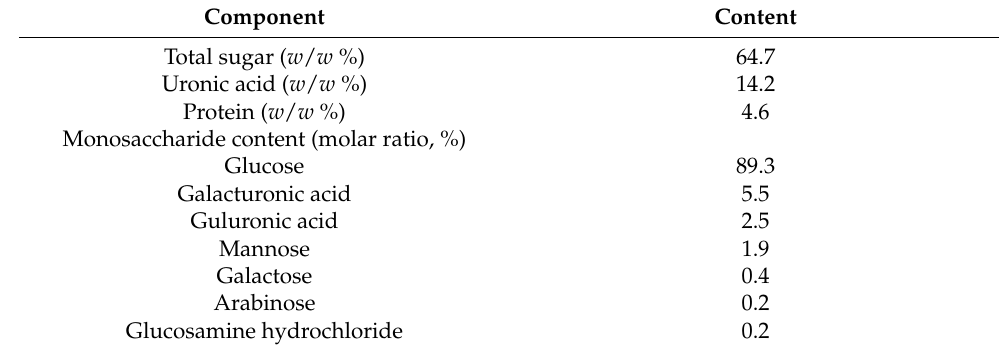
Table 1. Chemical composition of